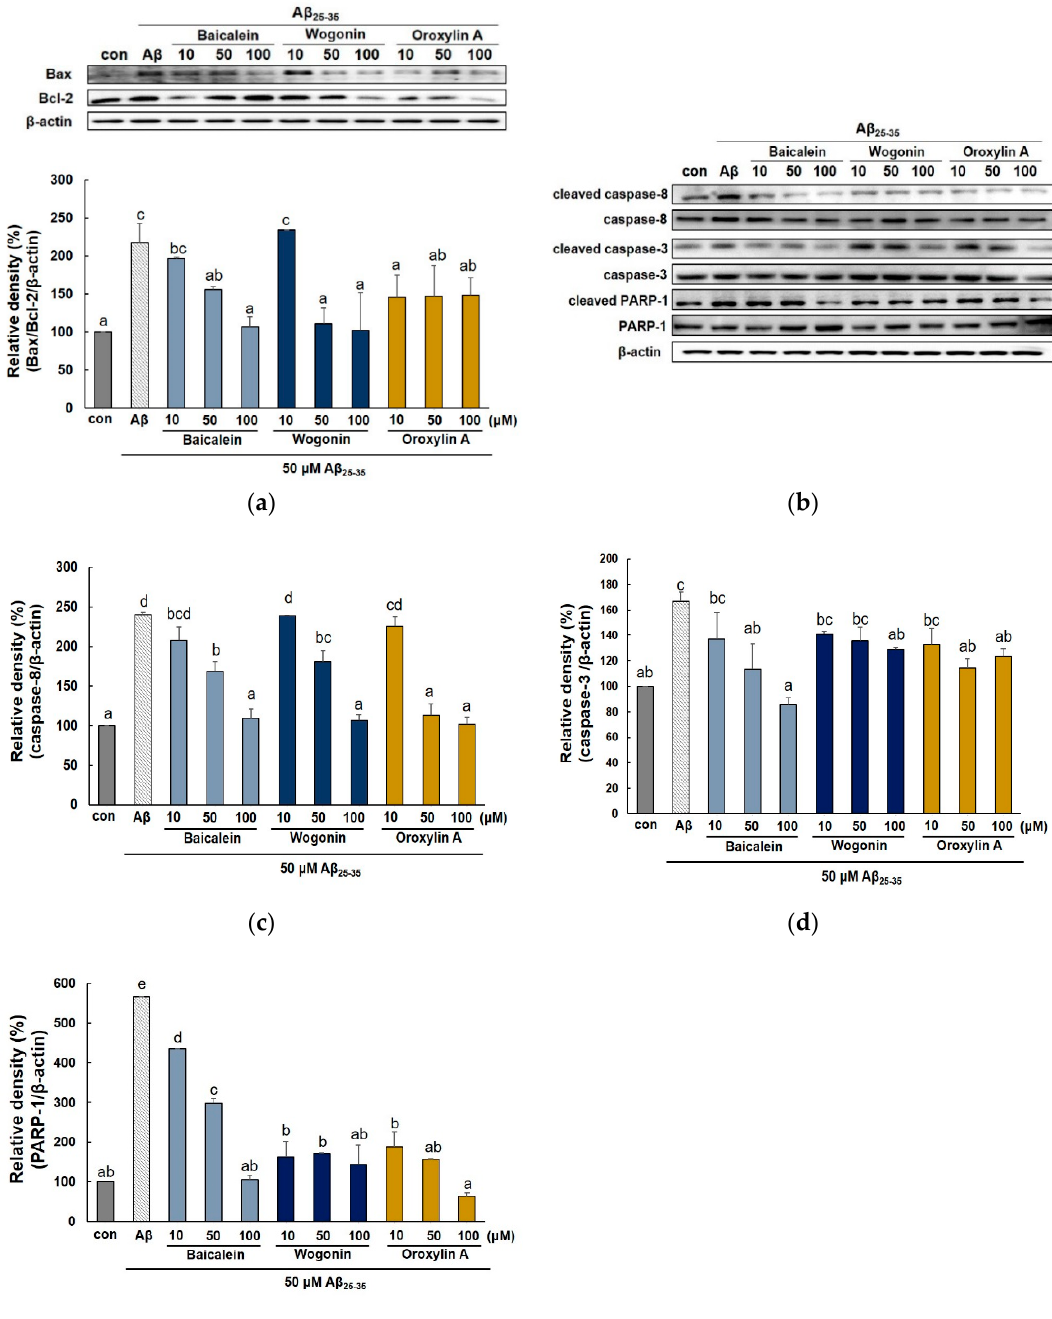
Figure 6. Effects of baicalein, wogonin, and oroxylin A on the expression of apoptosis-related biomarkers in A β 25–35 -induced PC12 cells. The cells were pretreated with samples for 1 h and stimulated with A β 25–35 for 24 h. Protein expression of Bax/Bcl-2 ratio, caspase-8, caspase-3, and PARP1 were determined using a western blotting ( a – e ). Different alphabets indicated significant difference at p < 0.05.